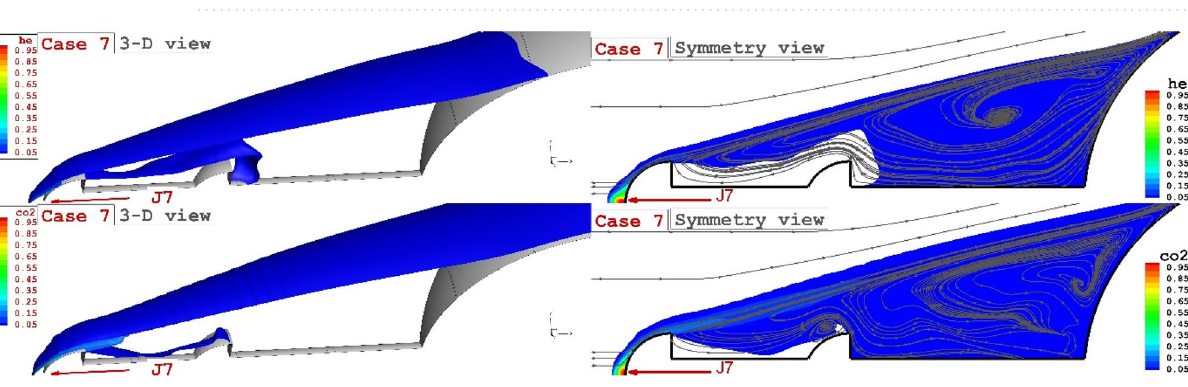
Figure 7. 3-D feature of the coolant jets (helium and CO 2 ) on the structure of the flow stream nearby the main body.